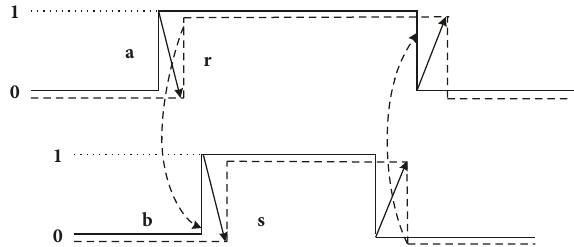
Figure 6: Strong-strong synchronization requirement.